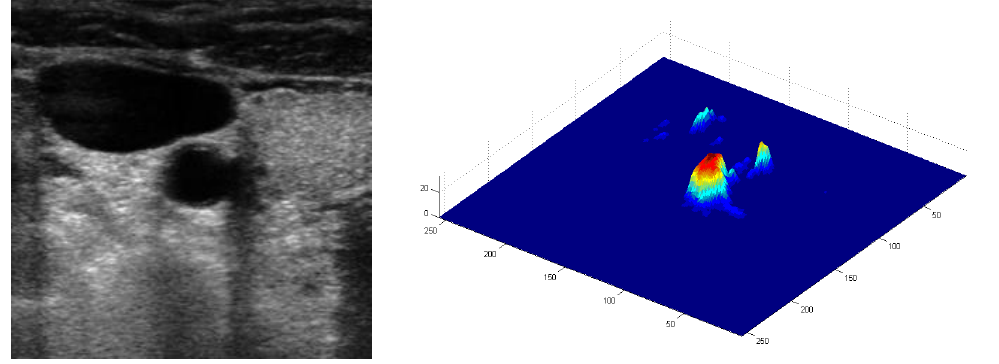
Figure 3. ( a ) Original image and ( b ) saliency map after applying fast radial